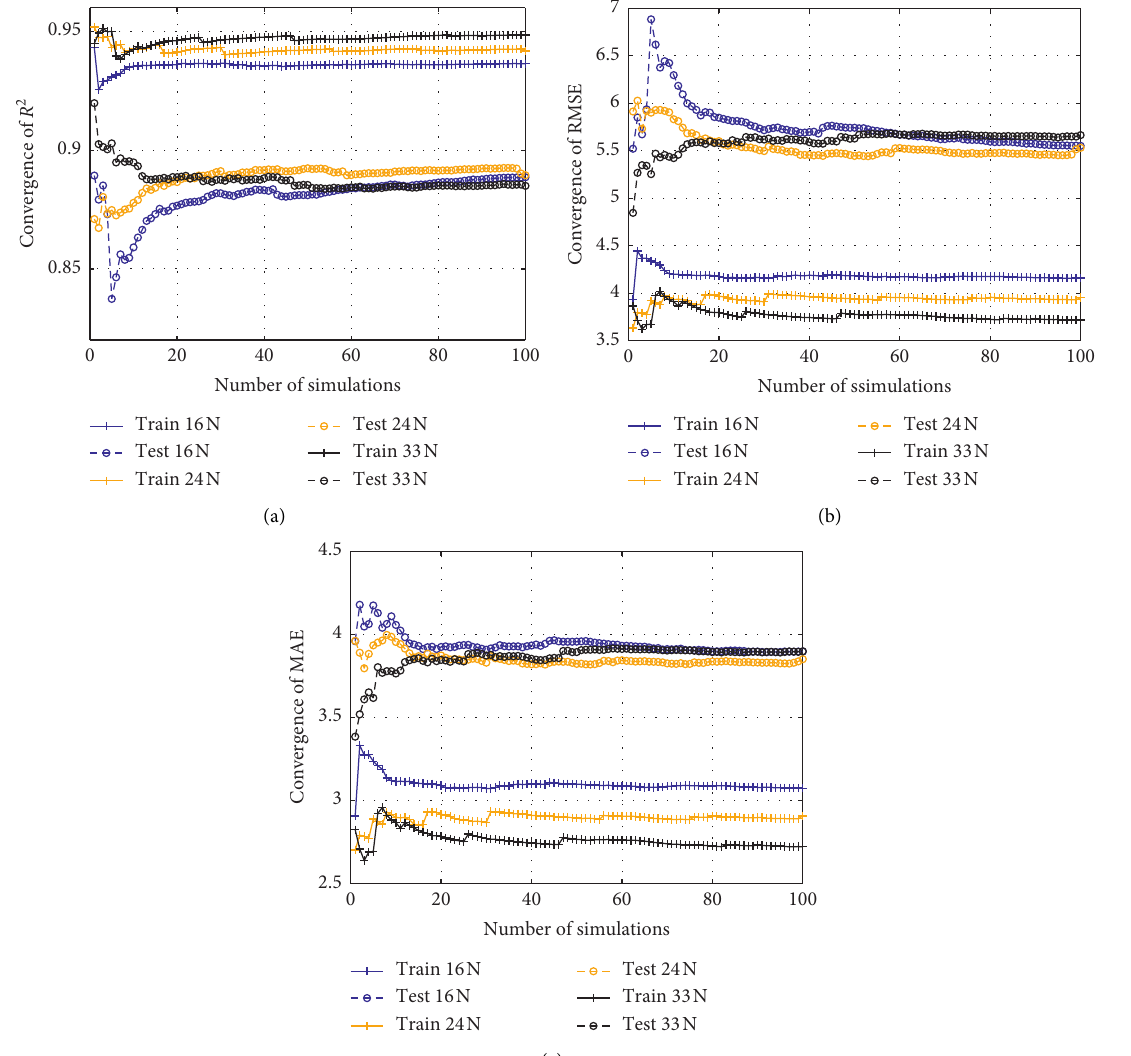
Figure 7: Analysis on the convergence of prediction results with respect to statistical measurements of different ANN structures over 100 simulations: (a) R 2 , (b) RMSE, and (c)